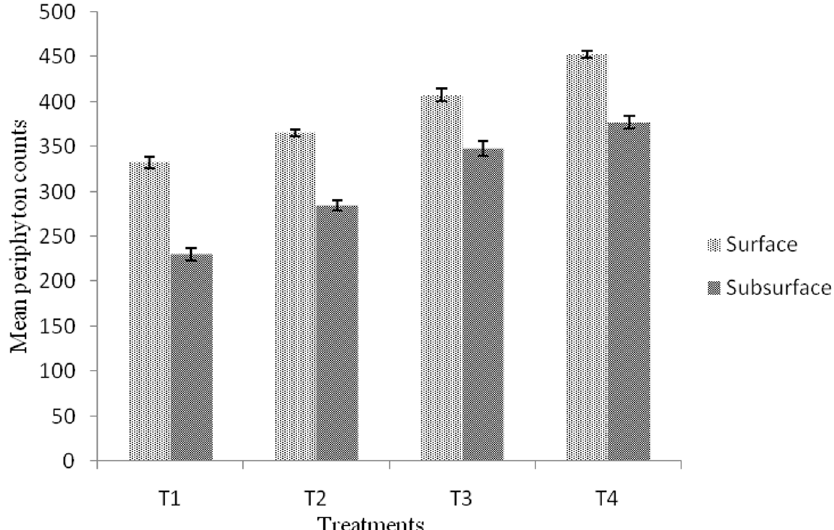
Fig. 2. Mean periphyton counts (no./cm 2 /day) at surface and subsurface levels of ponds under four different treatments during the study period.